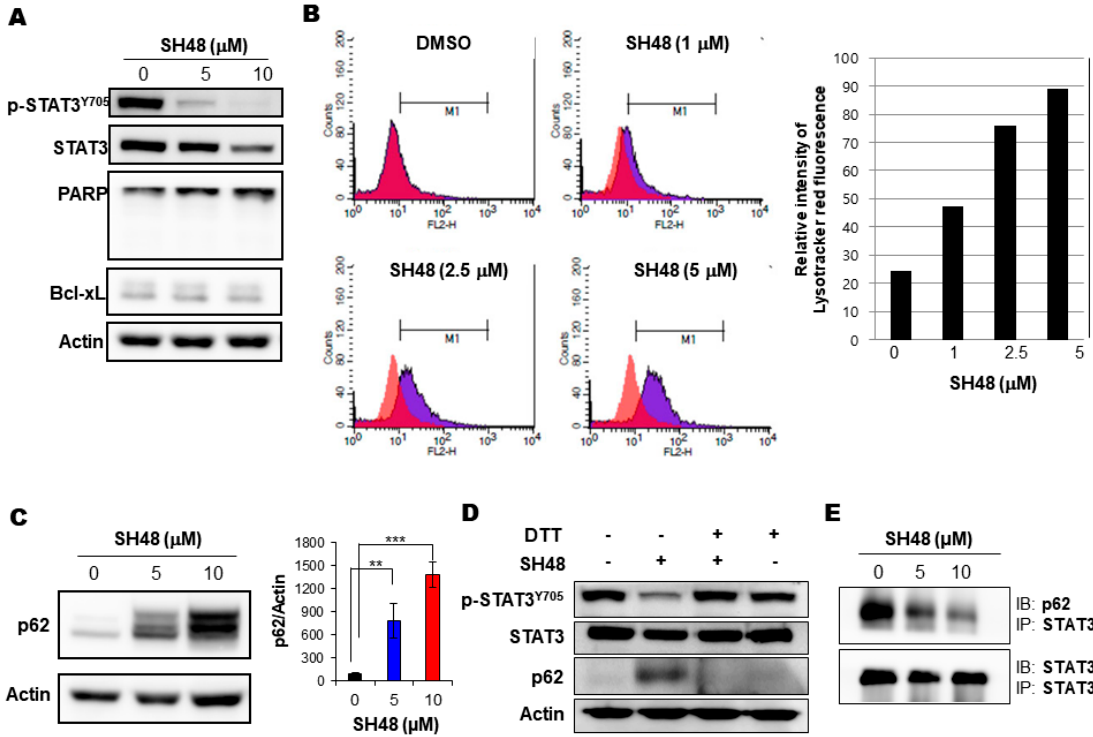
Figure 7. Induction of autophagy by SH48. ( A ) MCF10A- ras cells were treated with SH48 for 24 h. Lysates were immunoblotted with the indicated antibodies. ( B ) MCF10A- ras cells were treated with indicated concentrations of SH48 for 24 h and then incubated with 100 nM LysoTracker Red for 30 min. The cells undergoing autophagic death were identified by FACS analysis. ( C ) SH48-induced expression of autophagy marker proteins, LC3II and p62 by Western blot analysis. ** p < 0.01; *** p < 0.001. ( D ) Effects of the thiol-reducing agent DTT on SH48-induced STAT3 phosphorylation and p62 expression. MCF10A- ras cells pretreated with 0.5 mM DTT for 1 h, followed by 10 μ M SH48 for 24 h. ( E ) Direct interaction between p62 and its inhibition by SH48. MCF10A- ras cells were treated with indicated concentrations of SH48 for 24 h. Protein lysates were immunoprecipitated with STAT3 antibody followed by Western blot analysis with anti-p62 antibody.